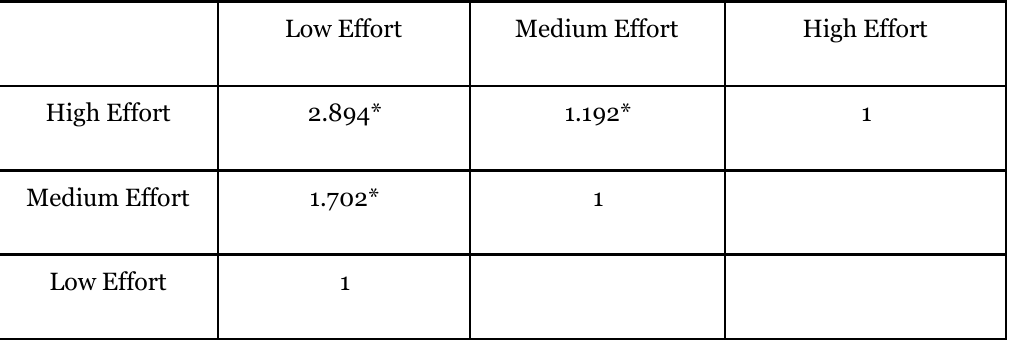
Scheffe Test for the Low Extraneous Load Group (N =